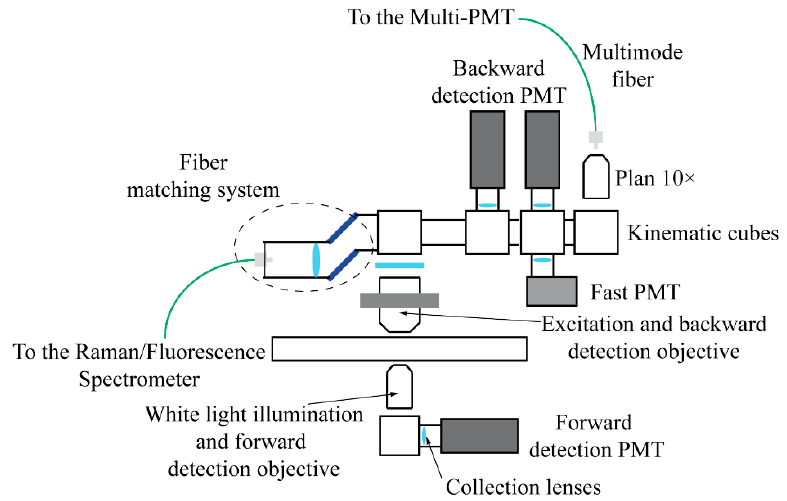
Figure 2. The detection system is composed by five kinematic cubes that hold filters and mirrors to send the light signals to the corresponding detectors. Spectral measurements are acquired by a spectrometer optically coupled through an optical fiber; alternatively, four PMTs enable epi and trans detection for multiphoton imaging and FLIM, while another multimode fiber transmits the collected light to a multispectral detector for SLIM measurements.